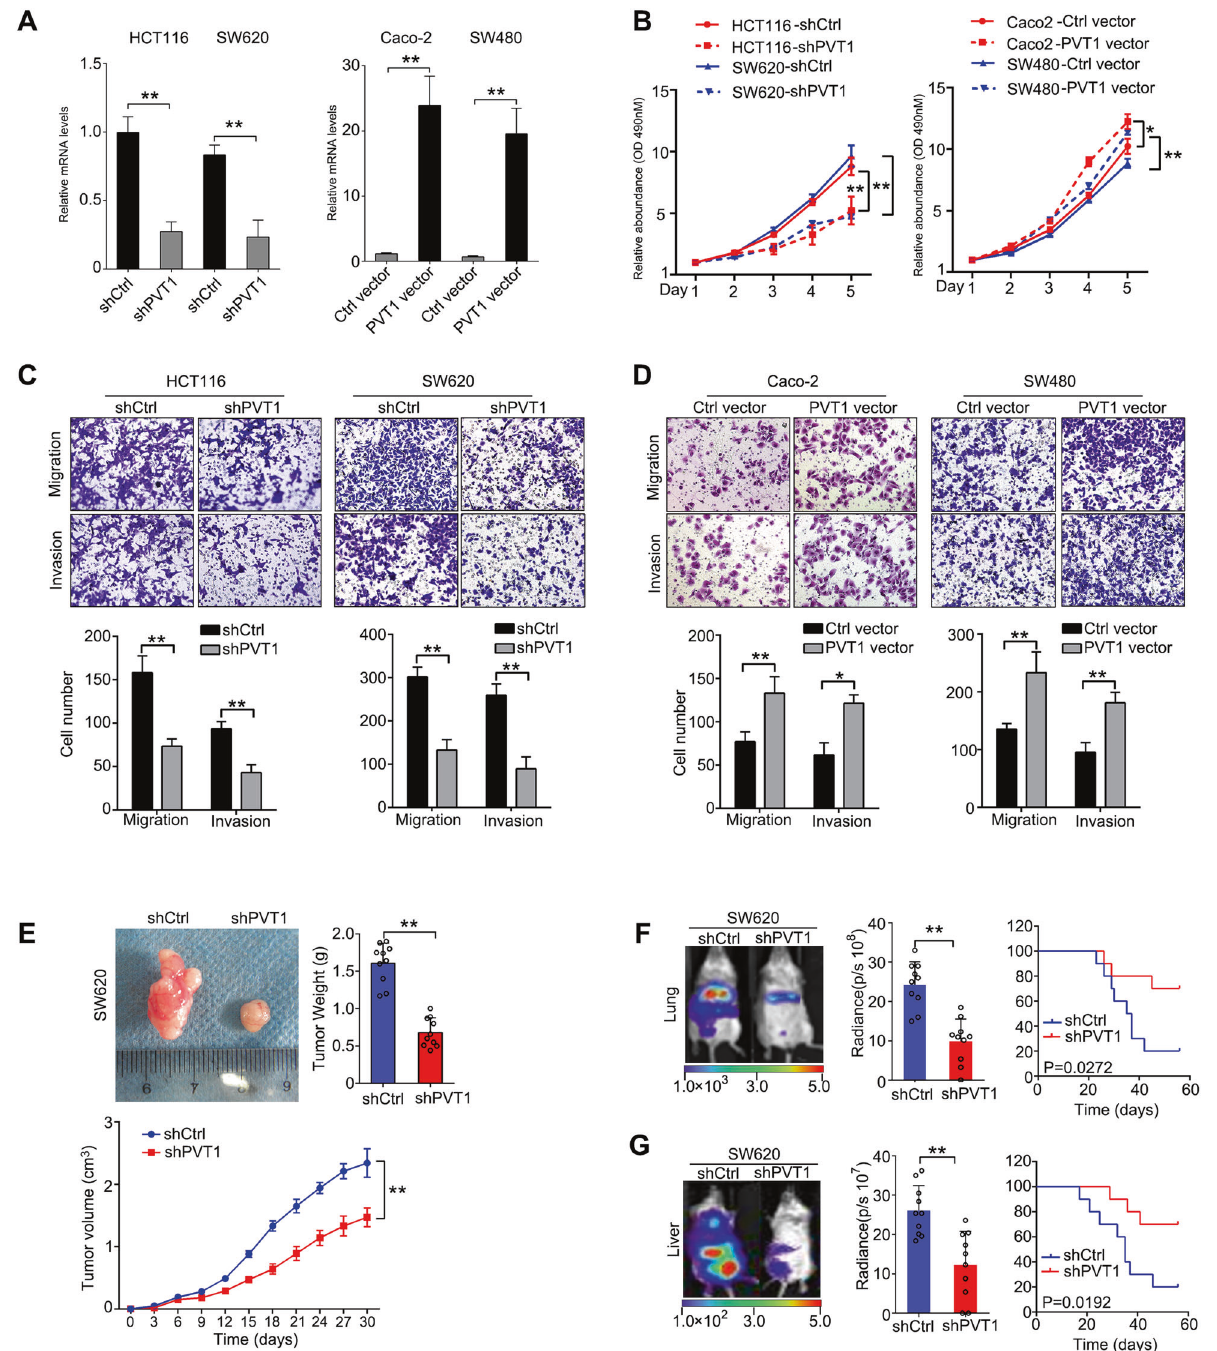
Fig. 5 LncRNA PVT1 promotes CRC growth and metastasis. A Left: qRT-PCR assays showing PVT1 expression in HCT116 and SW620 cells infected with Lenti-shPVT1 or control (left), and Caco-2 and SW480 cells infected with PVT1 overexpressing vector (right). B Left: XTT assay of HCT116 and SW620 cells infected with Lenti-shPVT1 ( N = 5). Right: XTT assay of Caco2 and SW480 cells infected with PVT1 vector ( N = 5). C Representative images in transwell assays of migration and invasion using Lenti-shCypB-infected HCT116 and SW620 cells (top) and statistical analysis (bottom). D Representative images in transwell assays of migration and invasion using Lenti-CypB-infected HCT116 and SW620 cells (top) and statistical analysis (bottom). E Representative images of tumors from SCID mice subcutaneously xenografted with SW620 cells infected with lentiviral shPVT1 or shNC vectors (top left, N = 5). Tumor weight (top right) and volume (bottom) of xenografted tumors derived from SW620 cells. F Left and Middle: Representative bioluminescent images and radiance levels of lungs in the different groups at 8 weeks after tail vein injection ( N = 10). Right: Overall survival times of the mice in the different groups. G Left and Middle: Representative bioluminescent images and radiance levels of livers in the different groups at 8 weeks after spleen injection ( N = 10). Right: Overall survival times of the mice in the different groups. The data are presented as the means ± SDs. * P < 0.05; ** P < 0.01; N.S. not signi fi cant.